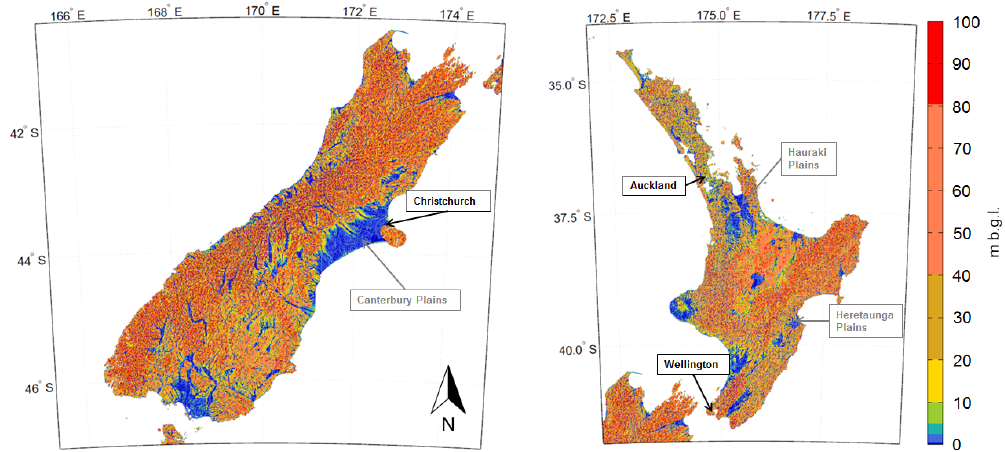
Figure 1. EWT water table depth in New Zealand, after Fan et al. (2013a). Main cities (black text boxes) as well as main alluvial aquifer are pointed out (grey text